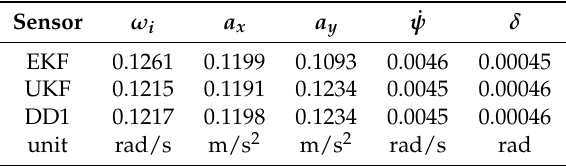
Table 1. Estimation error RMS during normal driving situation.